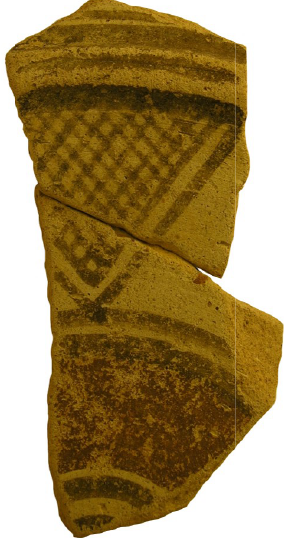
Figure 17. Black Slip Bichrome II plate, AIS 0588.008, W. 4.6 cm, ©